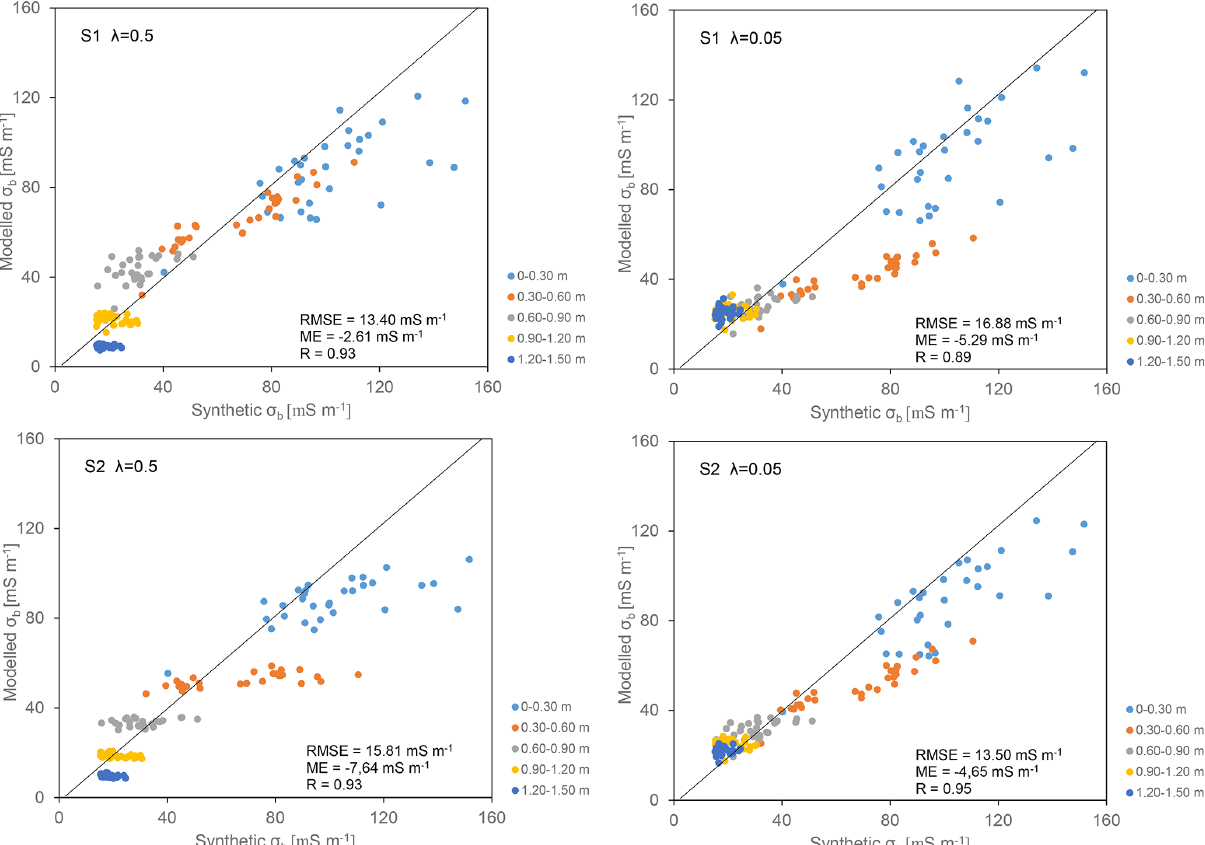
Figure 11. Synthetic versus modelled σ b distribution for four different combinations of S and λ inversion parameters. Different colours refer to different depths. Main statistics are also